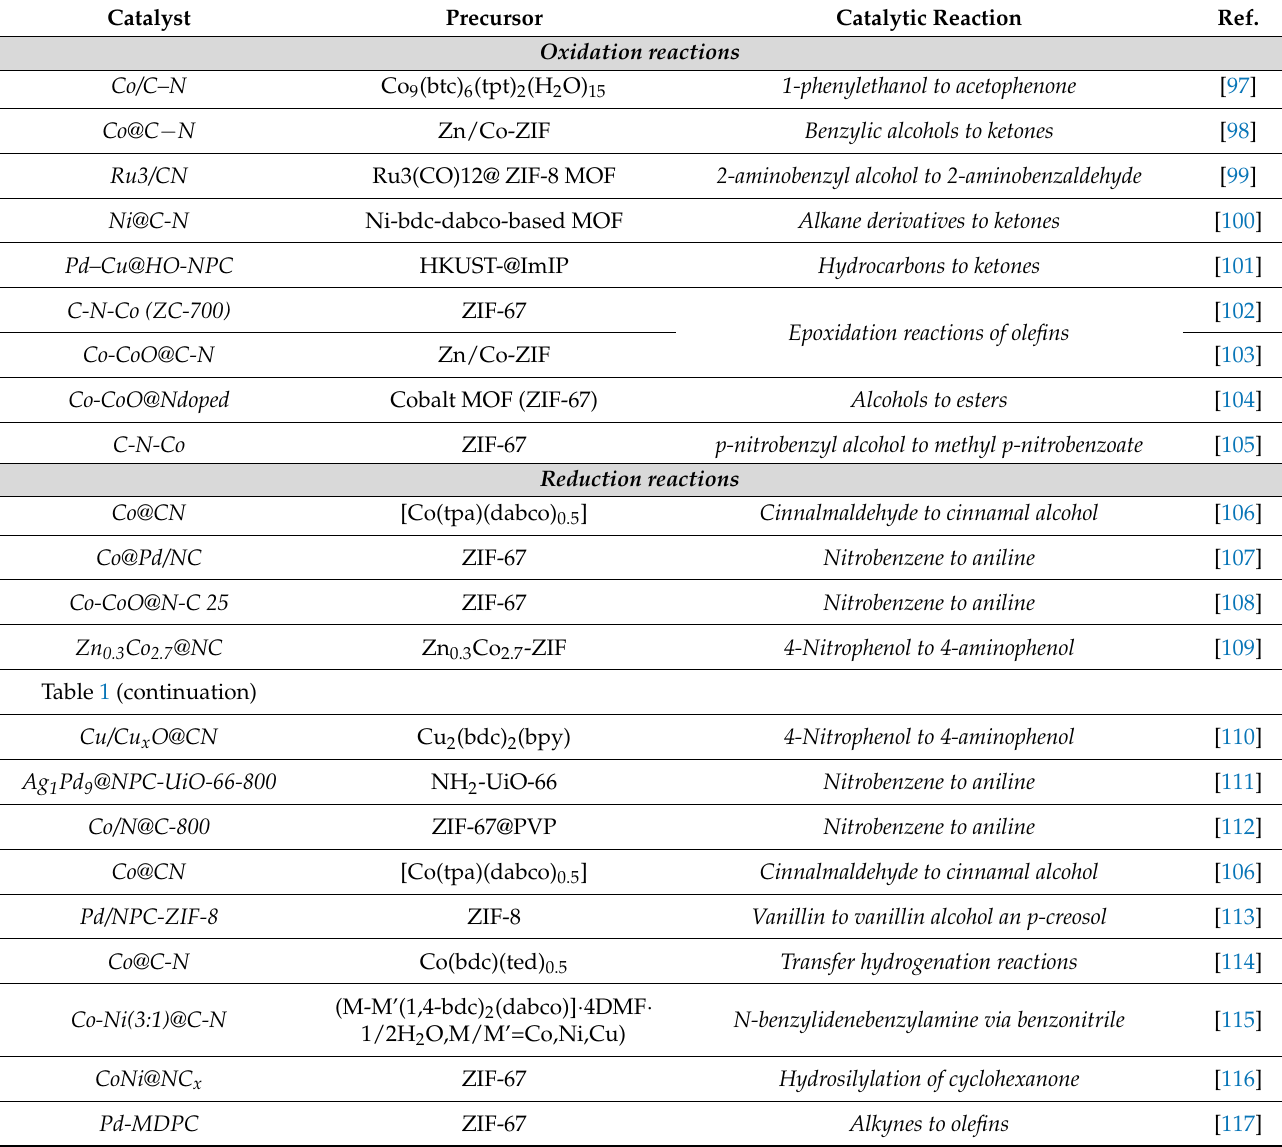
Table 3. Metal N -doped MOF-derived porous carbon catalysts applied in fine chemical